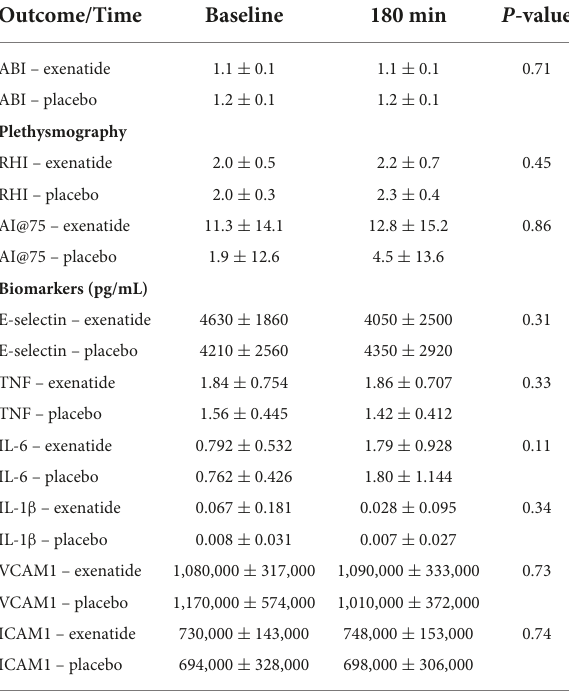
TABLE 3 Data of secondary